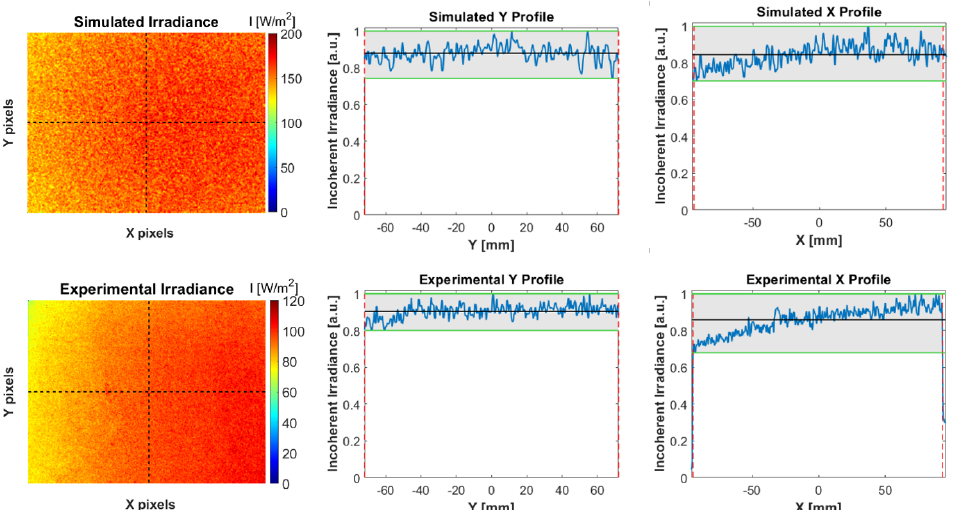
Figure 4. Intensity profiles at the target plane. On top, the ZEMAX simulations under conditions mimicking the experimental setup: d ≈ 1 m from the back vertex of the condenser, 191 mm × 144 mm field of view (FOV), 656 × 498 pixels, 5 × 10 7 analysis rays. On the bottom, the experimental results obtained with a spatially and spectrally uniform target. The decreasing irradiance along the horizontal (X) direction of the FOV was a result of the 15 ◦ tilt between LED and imaging system. Noise in the top-hat section of the simulated profiles was a consequence of discrete ray